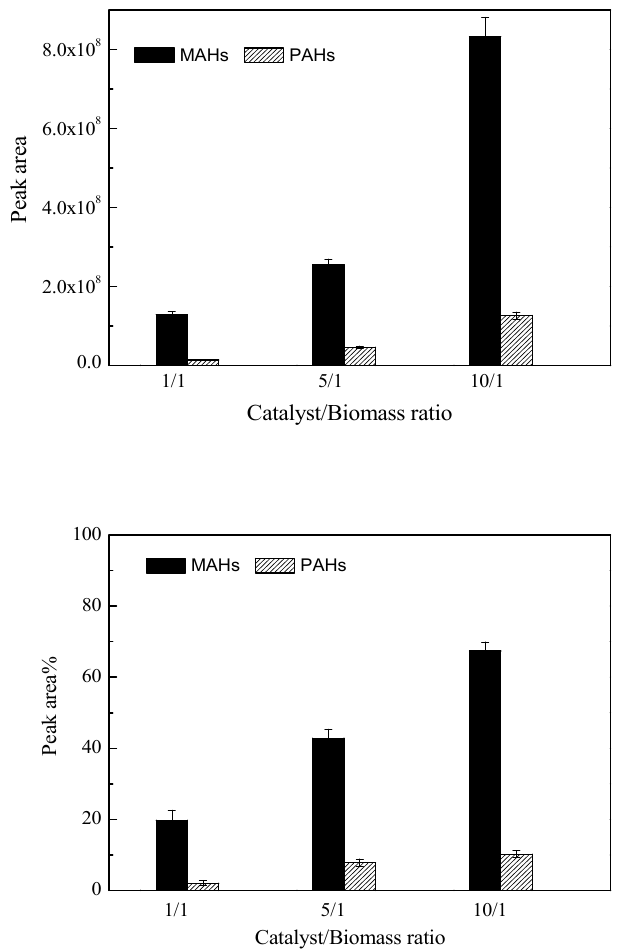
Figure 6. E ff ects of catalyst / biomass mass ratios on the yields and selectivity of aromatics. (10Mo / ZSM-5, Figure 6. Effects of catalyst/biomass mass ratios on the yields and selectivity of aromatics. T = 600 ◦ (10Mo/ZSM-5, T = 600 °C).